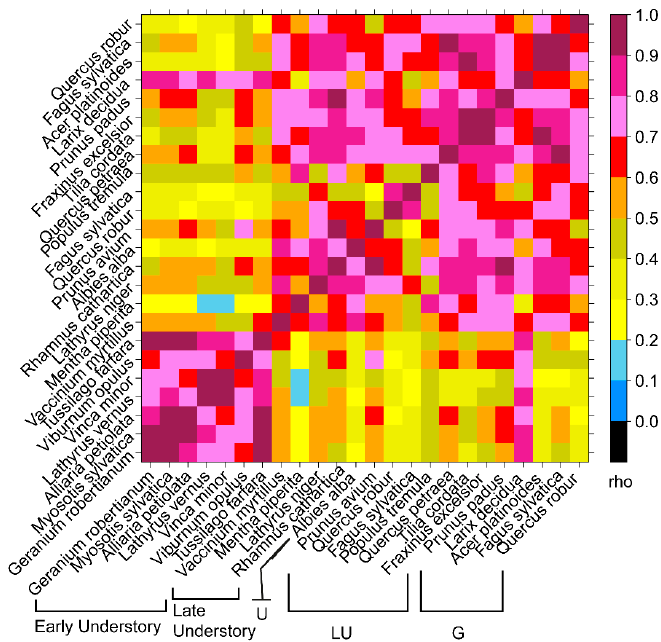
Figure 7. Spearman’s rank correlation matrix for selected species-specific GP-SOS; the heatmap confirms that the phenology of many late understory species is highly correlated with broadleaf tree phenology. Note: Species are arranged in increasing order of their mean SOS; refer to Supplementary Table S1 for details of species-specific